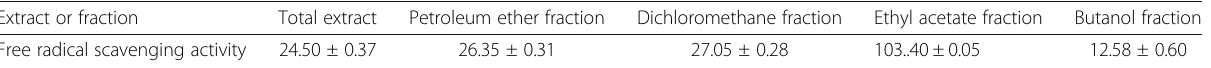
Table 3 Results of the total antioxidant capacities of the total ethanol extract and the different fractions of C. myxa L. leaves using phosphomolybdate assay Extract or fraction